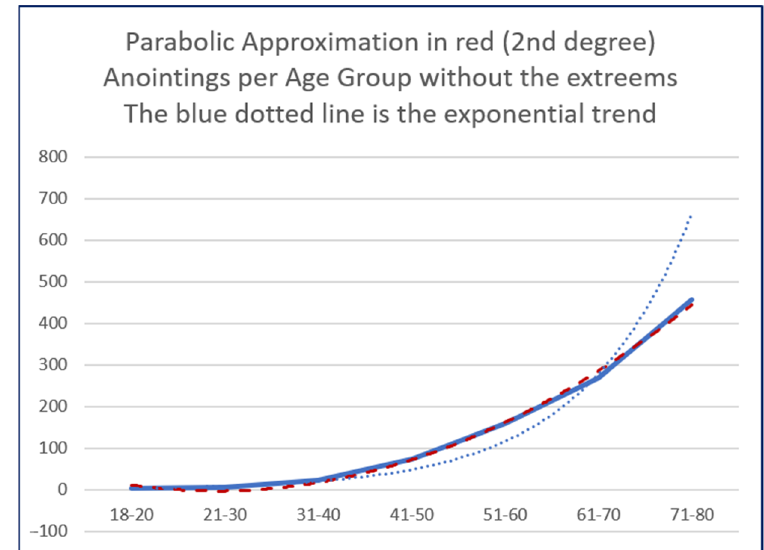
Figure 5. Anointings per age group.